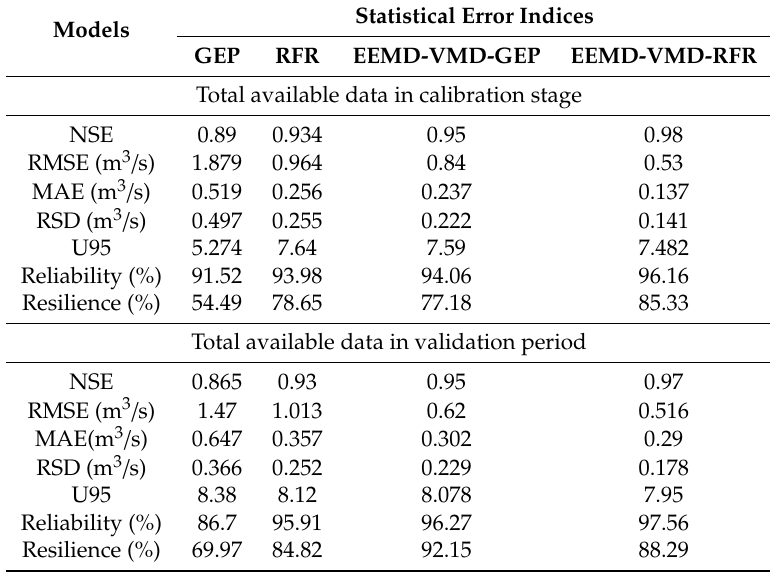
Table 9. Evaluation metrics of the proposed models in the calibration and validation periods at the Gachsar station.